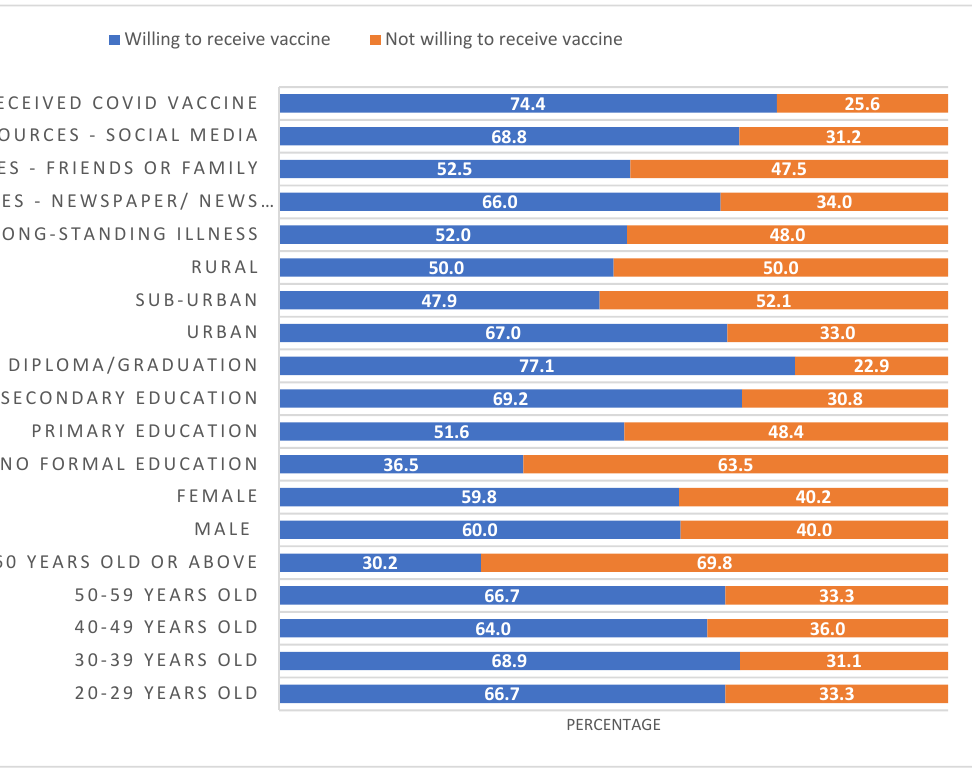
Figure 1. Percentage of unvaccinated participants willing or not willing to receive the vaccine in each of the patient-related categories. Table 4. Demographics of unvaccinated patients by their willingness to receive their vaccine. (n = 322).